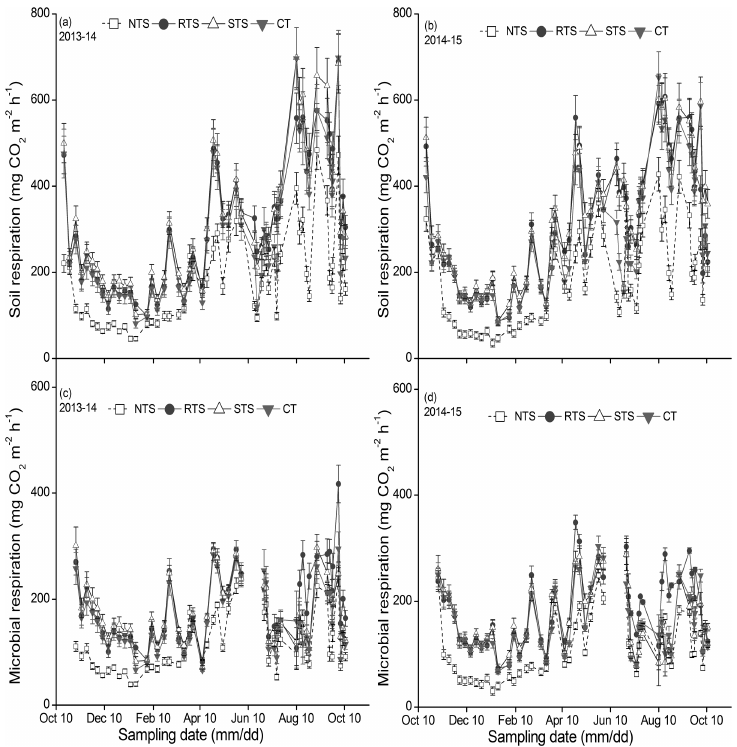
Fig 2. Season variations of soil respiration (a, 2013–14; b, 2014–15), microbial respiration (c, 2013–14; d, 2014– 15) during the cycle of wheat-maize rotation in 2013–2015 in Yangling, China. (NTS: no tillage with straw mulching; RTS: rotary tillage with straw incorporation; STS: chisel plow tillage with straw incorporation; CT: conventional moldboard plowing tillage without crop straw).